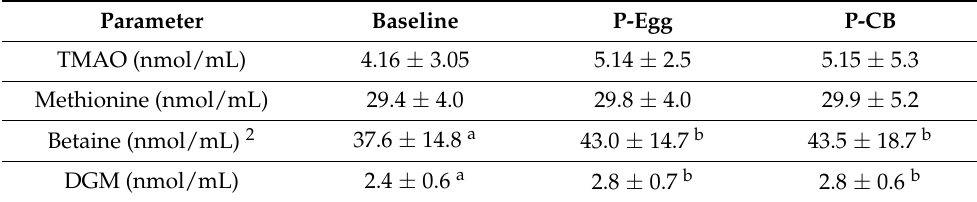
Table 1. Plasma concentration of choline metabolites at baseline and after consumption of 3 eggs/d (P-Egg) or after choline bitartrate (P-CB) supplementation for 4 weeks 1 .